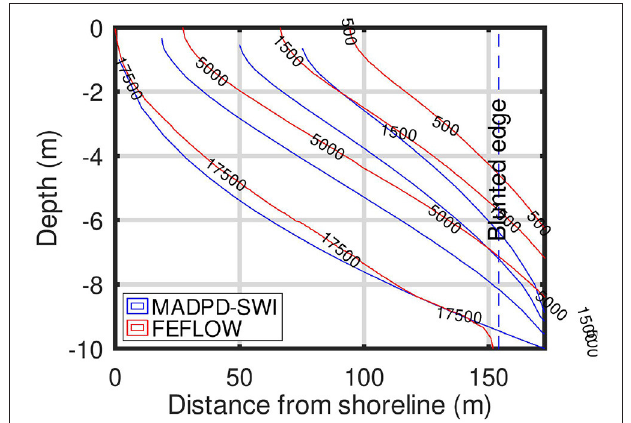
FIGURE 5 | Lines of constant salinity [ppm TDS] of the FEFLOW and 2D-MADPD-SWI solutions for α = 50.